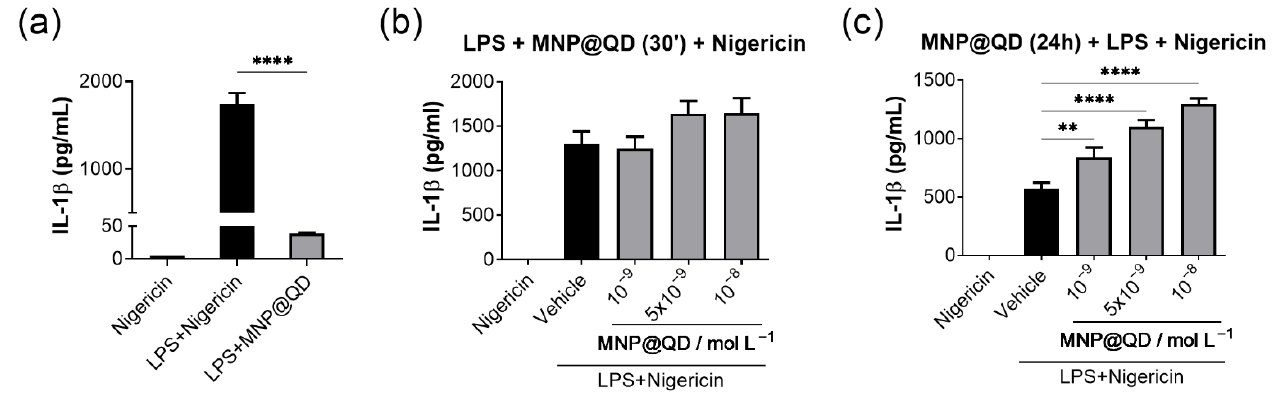
Figure 6. IL-1 β production by BMDCs. ( a ) Cells were primed with LPS for 3 h and treated with Nigericin or 10 −8 mol L −1 MNP@QD for 30 min. ( b ) BMDCs were treated with MNP@QD for 30 min after the 3 h-priming with LPS. Then, cells were treated with Nigericin for an additional 30 min. ( c ) BMDCs were incubated with MNP@QD for 24 h, then primed with LPS (3 h) and treated with Nigericin (30 min). IL- 1β production was evaluated in culture supernatants by ELISA. Each bar represents the average of four replicates. Error bars represent SEM. Graphs are representative of two independent experiments. ** p < 0.01; **** p < 0.0001. Statistical significance was obtained with One-way ANOVA with Sidak’s multiple comparisons test.